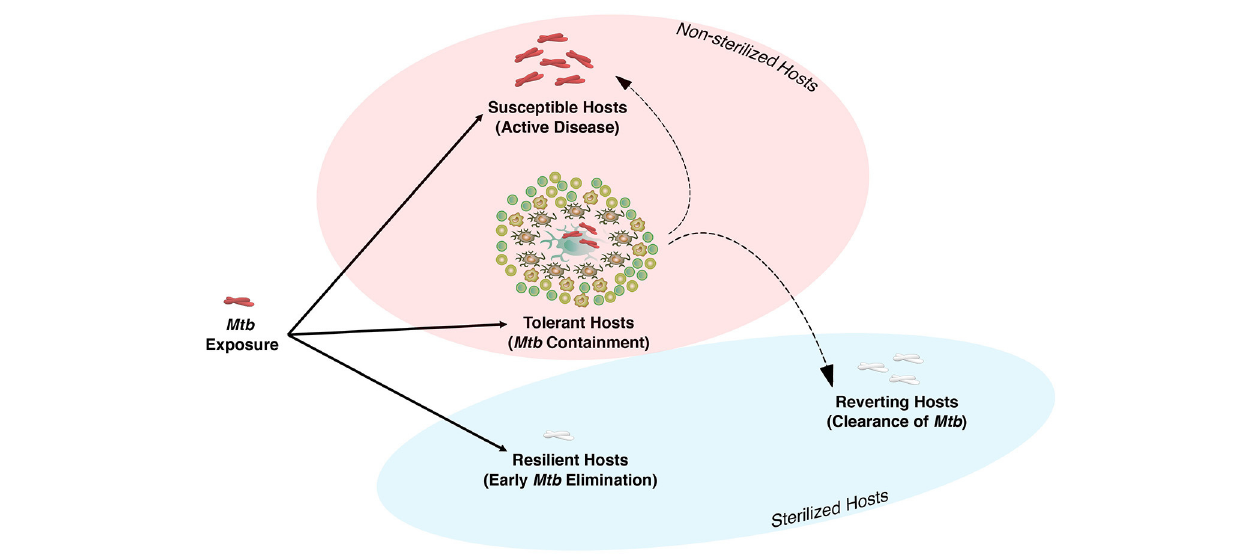
FIGURE 1 | The spectrum of Mycobacterium tuberculosis infection in humans . Humans and Mtb have co-evolved to reach a dynamic equilibrium. There are three major outcomes following exposure to Mtb . (1) Resilient Host: These individuals are able to eliminate the bacteria at the early stage of infection via host defense mechanisms of the upper or lower airways. (2) Tolerance Host: if innate immunity is unable to eliminate Mtb , the host initiates adaptive immunity and granuloma formation, which is the beginning of the chronic phase of infection and disease tolerance to contain or ultimately eliminate Mtb (reverting host). Conditions associated with immunocompromised host may result in loss of Mtb containment and active disease in tolerant host. Although 90–95% of individuals are considered to be tolerant hosts, the exact number of these individuals who are able to clear Mtb or succumb to disease is still unknown. (3) Susceptible Host: individuals with impaired natural immunity to Mtb who progress to active disease and transmit the